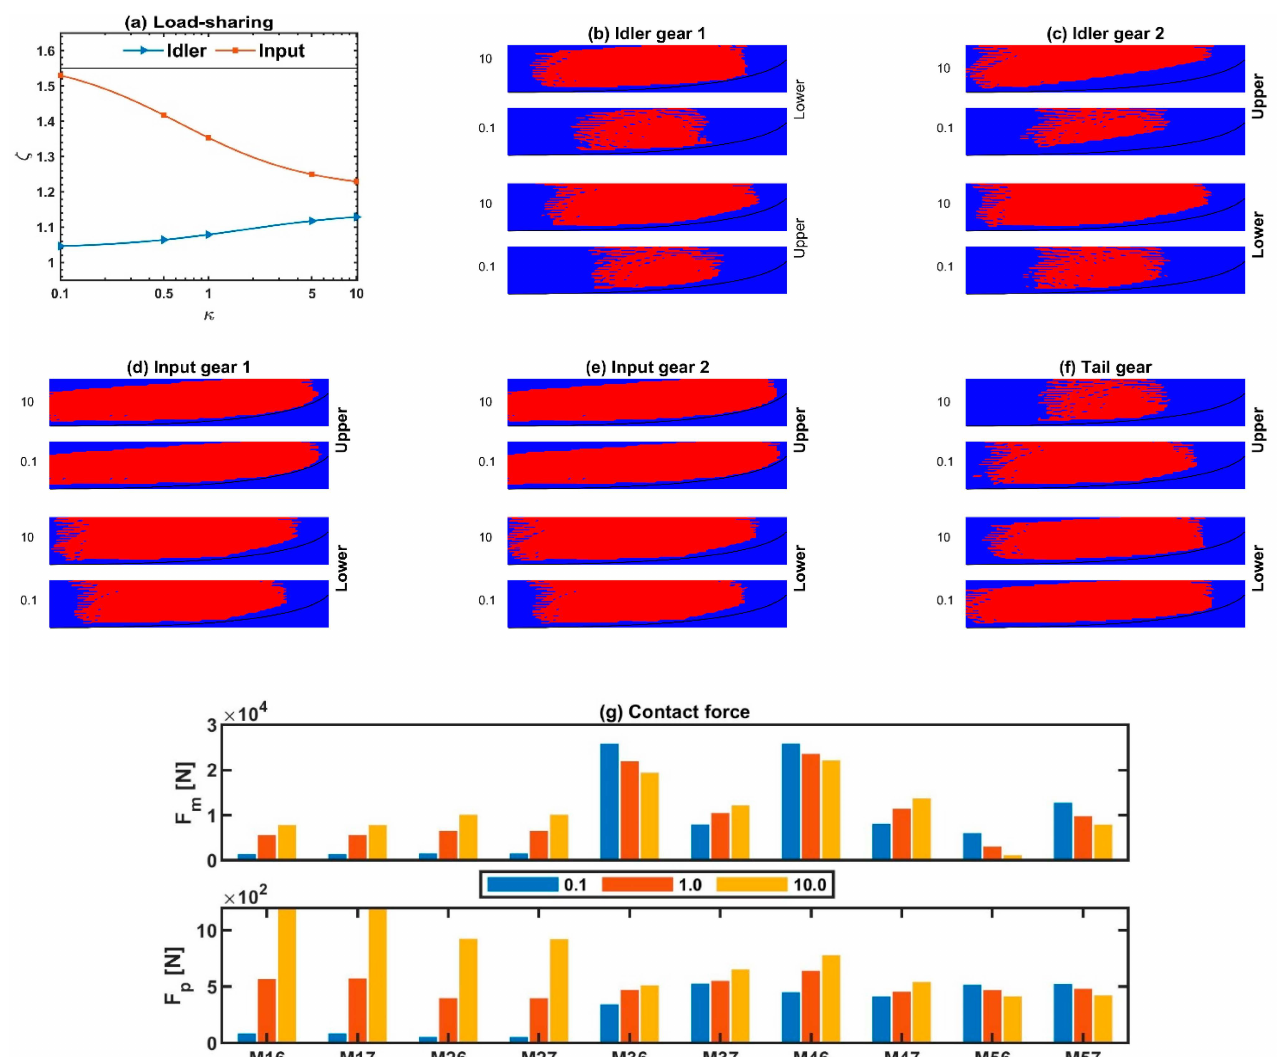
Figure 8. Influence of the support stiffness of the idler gear on the load-sharing and contact